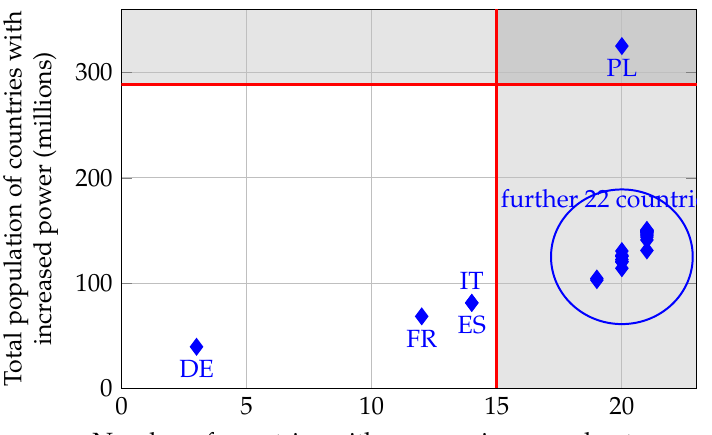
Figure 6. Effect of a departure from the EU after Brexit with populations for 2015, adjusted Shapley– Shubik